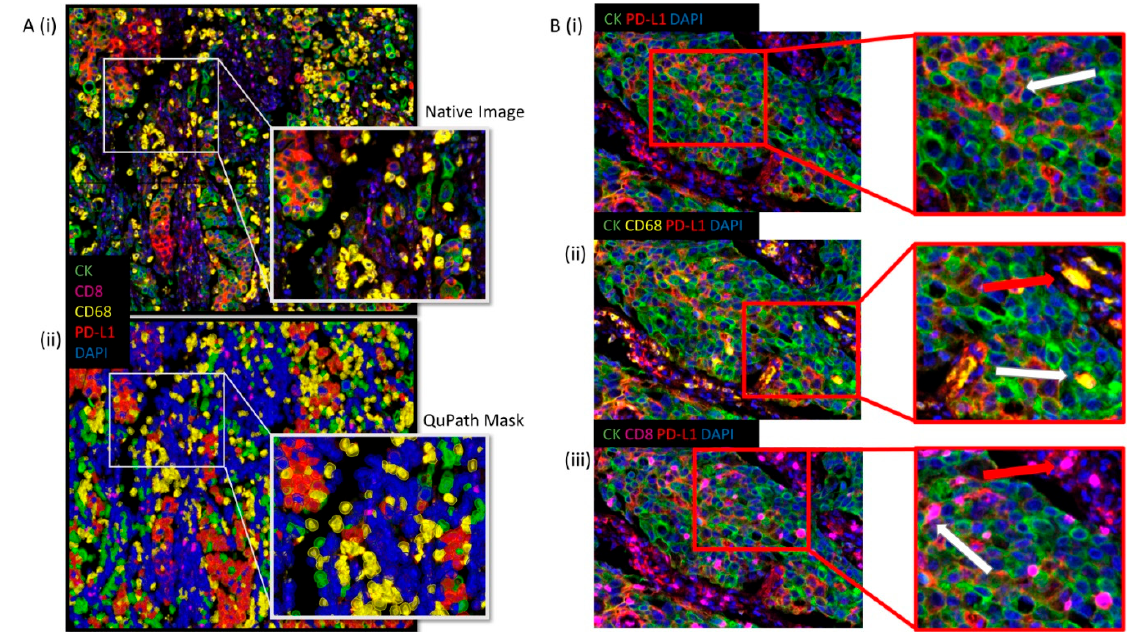
Figure 3. Optimised digital image analysis (DIA) assessment of the mIF staining. ( A ) ( i ) represents the composite mIF staining panel with nuclei (blue), PD-L1 (red), CK (green), CD68 (yellow), CD8 (purple). ( A ) ( ii ) displays the QuPath mask of the combined multiplex with nuclei (blue), PD-L1 (red), CK (green), CD68 (yellow), CD8 (purple). ( B ) ( i ) displays only PD-L1 positive, cytokeratin positive channels, while ( B ) ( ii ) and ( iii ) display the addition of CD68 and CD8, respectively.